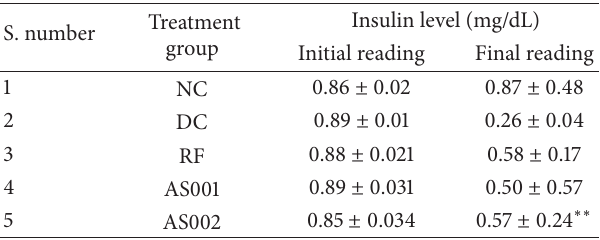
Table 4: Effect of Pupalia lappacea on insulin level of STZ induced diabetes in rats.